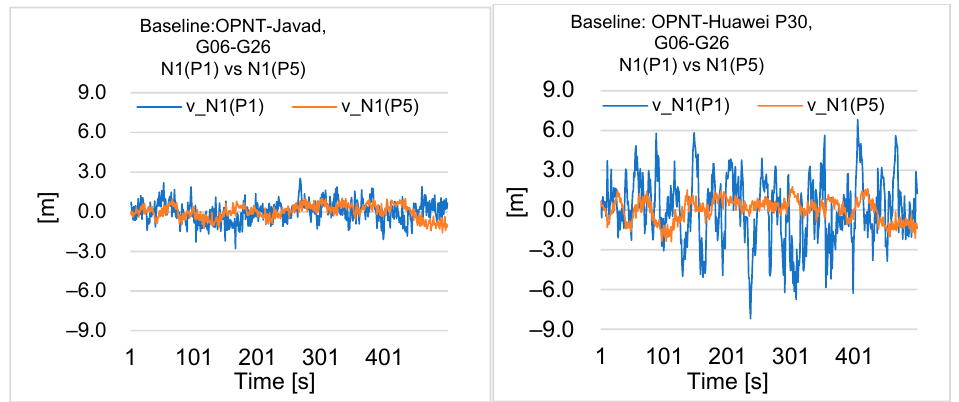
Figure 23. Time series of double-difference residuals for float N1(P1) and N1(P5) solutions from single measurement epochs based on the use of only one pair of G06–G26 satellites (500 epochs).